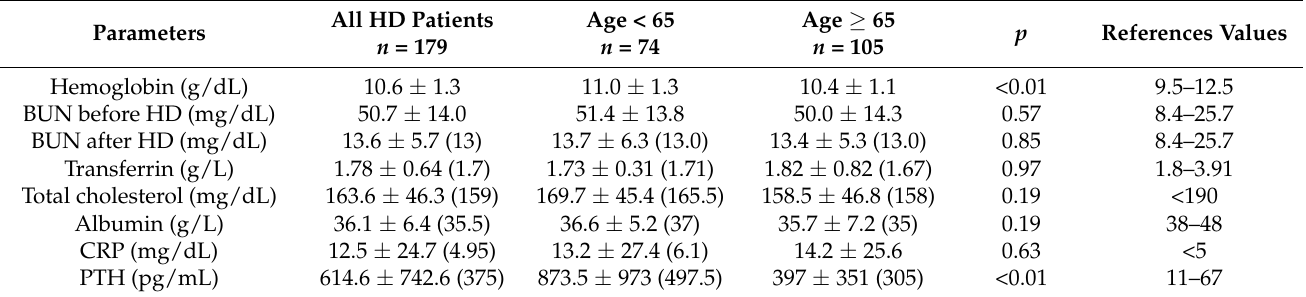
Table 6. Laboratory parameters in study groups.